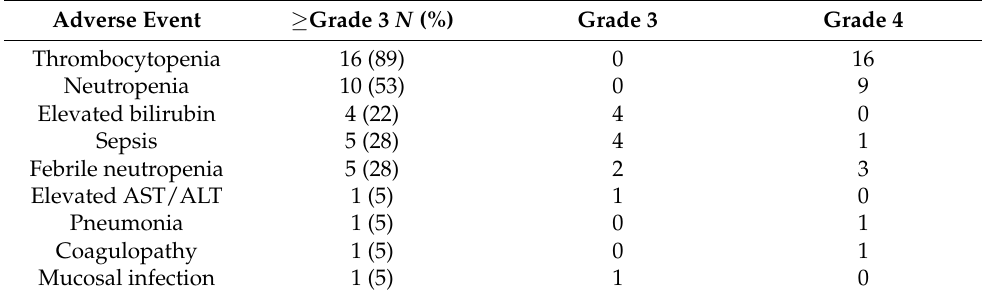
Table 3. Adverse events attributable to venetoclax per CTCAE